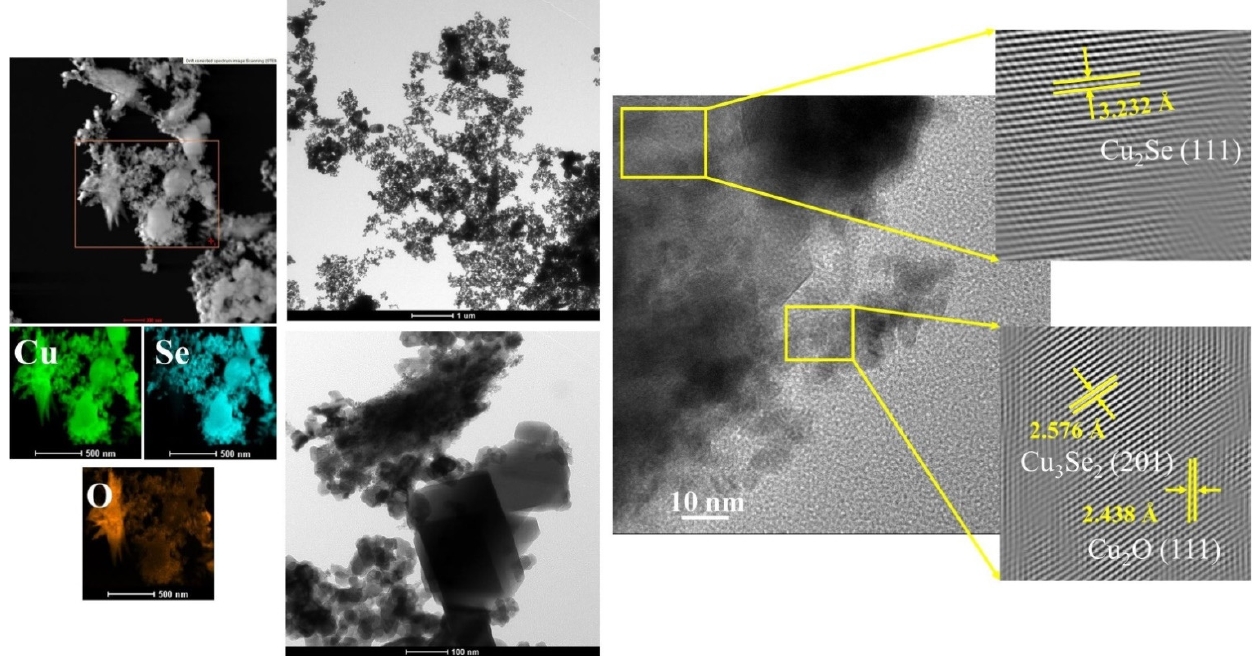
Figure 3. TEM results of Cu 2 Se samples.